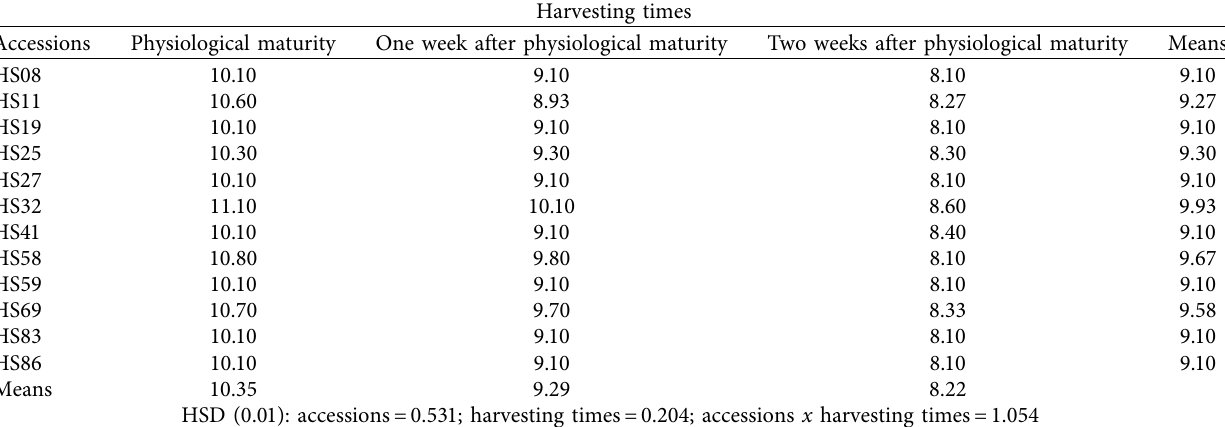
Table 1: Interactive effects of harvesting times x accessions on the seed moisture content of roselle.